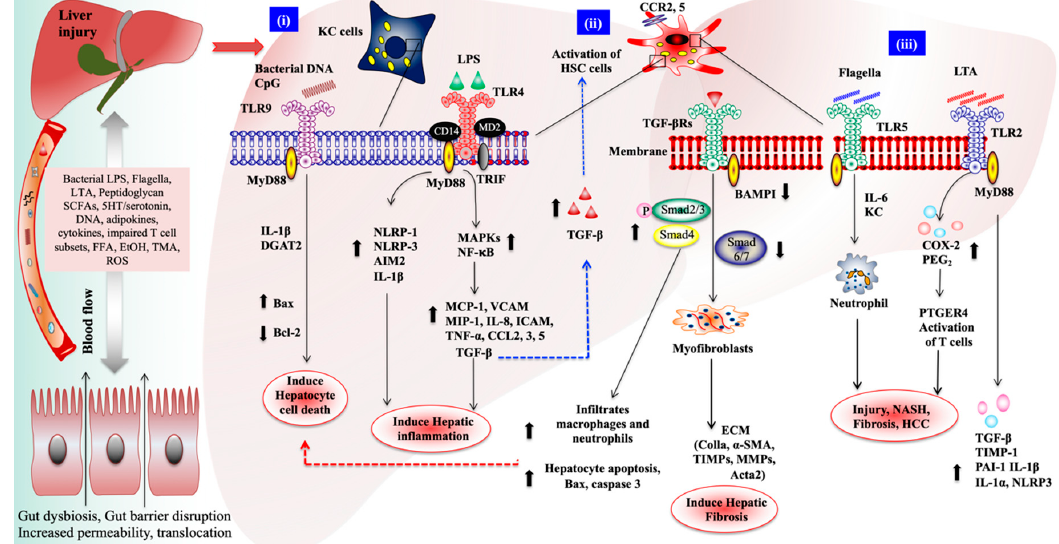
Figure 2. Schematic diagram of gut bacteria-derived components/metabolites on the promotion of liver diseases via the interactions with TLRs signaling. Chronic alcohol abuse and liver diseases induce gut dysbiosis, increase the gut permeability, bacterial overgrowth, systemic inflammation, resulting in the translocation of microbial components (lipopolysaccharides (LPS), lipoteichoic acid (LTA), flagella, and DNA), metabolites (short-chain fatty acids (SCFAs), trimethylamine (TMA), free fatty acids (FFAs), and ethanol (EtOH)), inflammatory cytokines, and impaired T cells to the liver via the portal and lymphatic circulation, where they mediate inflammatory signaling that has been shown to promote the development of non-alcoholic steatohepatitis (NASH), fibrosis, and hepatocellular carcinoma (HCC). (i) The interaction of bacterial DNA or CpG-DNA with TLR9 activates Kupffer cells (KCs) and increases the production of IL-1 β , which binds with IL-1R on hepatocytes, induces intracellular fat accumulation, and nuclear factor (NF)-kappa B (NF- κ B) activation, which promotes hepatic steatosis and cell death by increasing the level of Bax and decreasing the level of Bcl-2. The translocation of LPS activates TLR4/MyD88 signaling on both Kupffer (KC) and hepatic stellate cells (HSCs), and recruits IRAK, TRAF6, TAIK, and TAB to activate the mitogen-activated proteins kinase (MAPK) and NF- κ B pathways, resulting in the up-regulation of cytokines/chemokines production, including pro-fibrogenic transforming growth factor- β (TGF- β ). LPS also activates KC cells and induces the production of NLRP1/3 inflammasomes, AIM2, and IL-1 β , which contributes to the progression of liver fibrogenesis and HCC. (ii) KC and HSC cell-produced TGF- β stimulate fibrogenic transforming growth factor- β receptor 1 and 2 (TGF- β R1&2) signaling on HSC cells and induce liver fibrogenesis by up-regulating the Smad2/3/4 proteins and down-regulating bone morphogenic protein and activin membrane-bound inhibitor (BAMBI) (TGF- β receptor inhibitor) and Smad6/7. TGF- β /Samd3 signaling infiltrates more neutrophils and macrophages to the liver and increases hepatocyte apoptosis and the related protein expression, such as Bax cytochrome and cleaved caspase 3. The activation of HSC cells can recruit and stimulate hepatocytes, macrophages, and KC via paracrine signaling using TGF- β and connective tissue growth factor (CTGF). (iii) The translocation of lipoteichoic acid (LTA) and flagella can also promote liver injury, NASH, fibrosis, and HCC via the activation of respective TLRs (TLR2 and TLR5) signaling on KC and HSC cells [3,113,119–121,125,146,164,165]. Arrows indicates up and down-regulation of genes. Solid lines indicate production genes and dashed lines (blue and red) indicate further activation of HSCs and cell death. Abbreviations used in the figure are: Bone morphogenic protein and activin membrane-bound inhibitor (BAMBI), transforming growth factor- β receptor 1 and 2 (TGF- β R1&2), chemokine receptors (CCR2, 3, 5), diacylglycerol acyltransferase 2 (DGAT2), plasminogen activator inhibitor-1(PAI-1), tissue inhibitor of metalloproteinase-1 (TIMP1), prostaglandin E2 (PGE2), prostaglandin E receptor